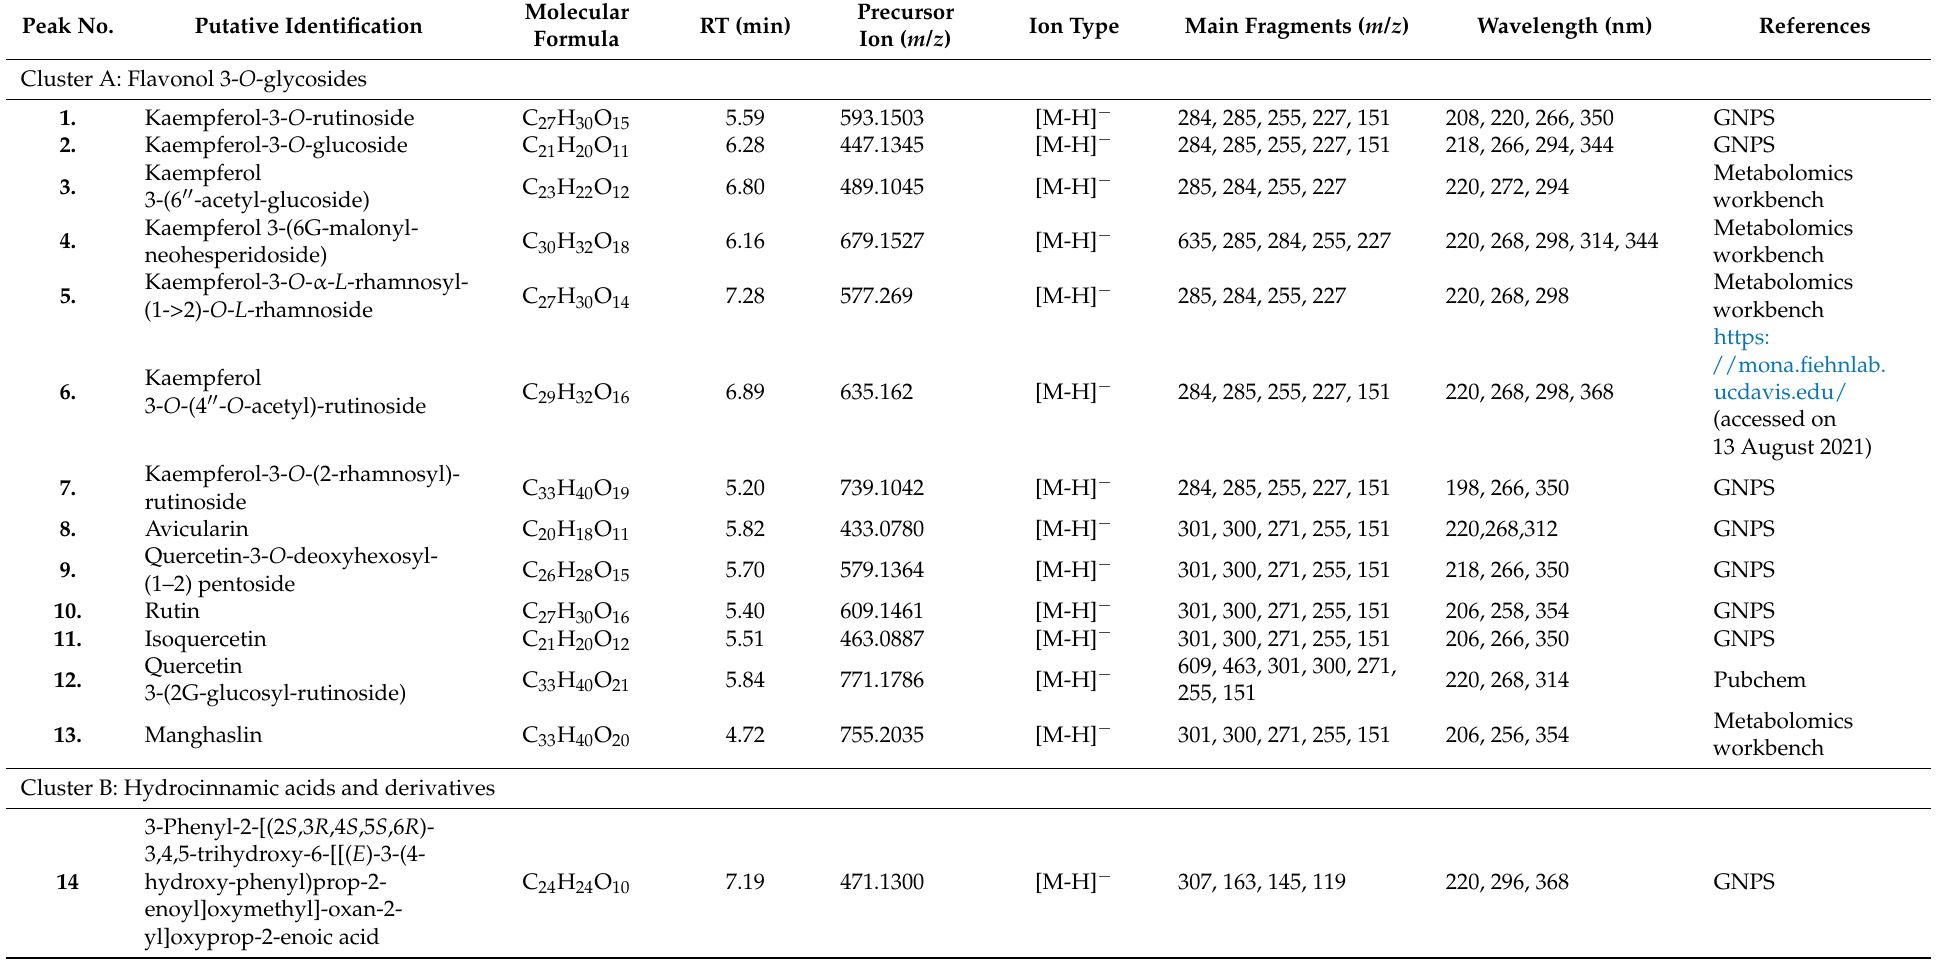
Table 1. The metabolites identified in the ethyl acetate fraction of flower Clitoria ternatea extract (CTF_EA). Peak